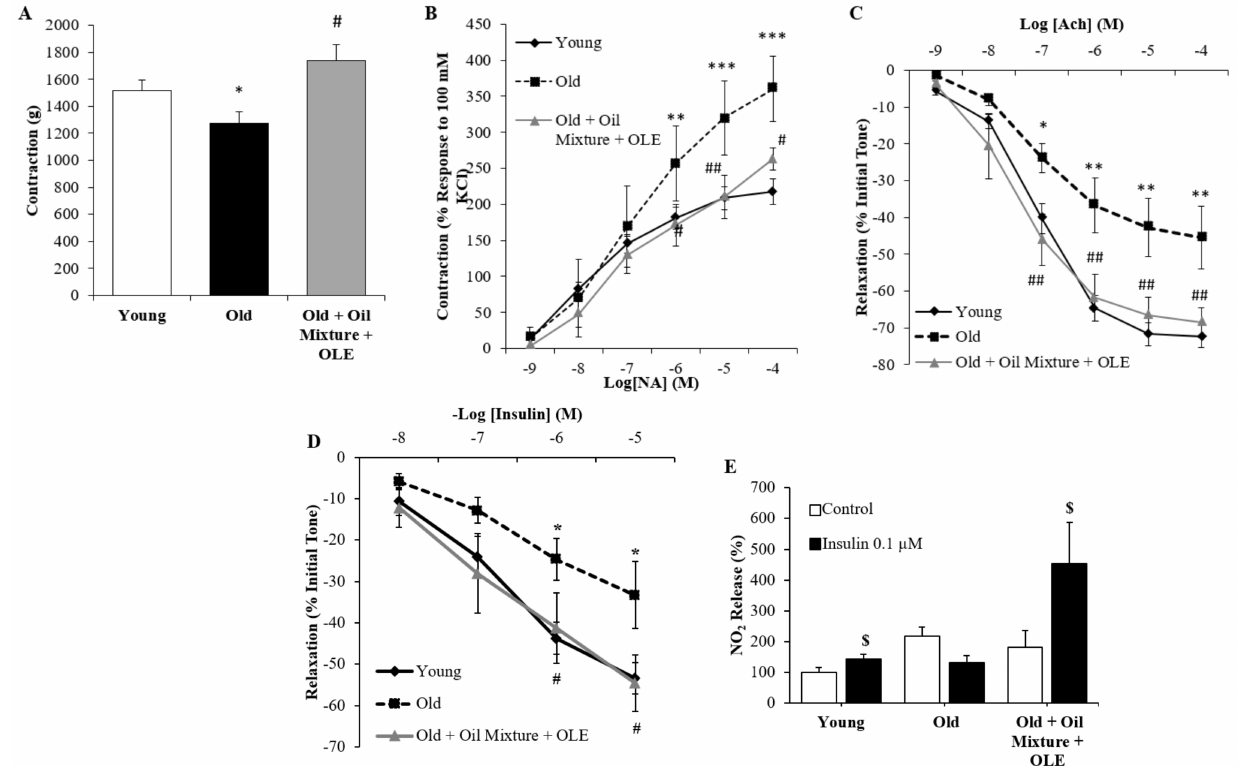
Figure 7. Contraction of abdominal aortic segments to potassium chloride 100 mM ( A ) and to norepinephrine ( B ); relaxation of thoracic aortic segments to acetylcholine ( C ) and to insulin ( D ); and nitrites released from aorta segments to culture medium in presence/absence of insulin (0.1 µ M) ( E ) of young rats, old rats and old rats treated 21 days with the Oil Mixture and the OLE. Values are represented as mean ± SEM. * p < 0.05 vs. Young; ** p < 0.01 vs. Young; *** p < 0.001 vs. Young; # p < 0.05 vs. Old; ## p < 0.01 vs. Old; $ p < 0.05 vs.